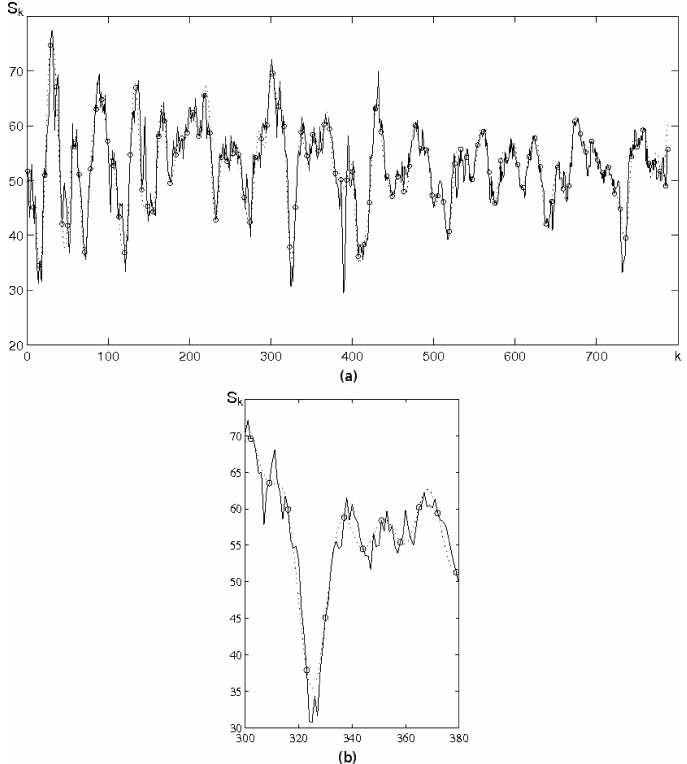
Fig. 5. PMI Composite Index data (the solid line) and an algebraic interpolant (the dotted line) of the experimental data at m = 56. Circles denote nodes of the equispaced grid; the zoomed part of the algebraic interpolant is illustrated in part